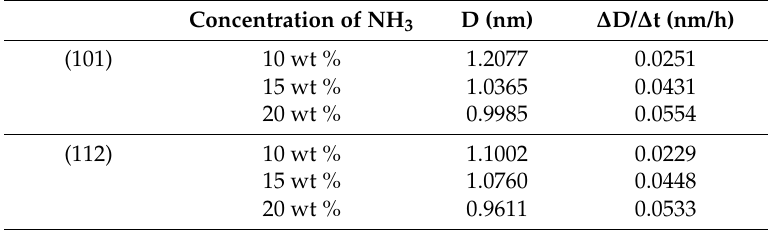
Table 3. Selectivity of crystal growth direction for NH 4 ReO 4 at different NH 3 wt %.